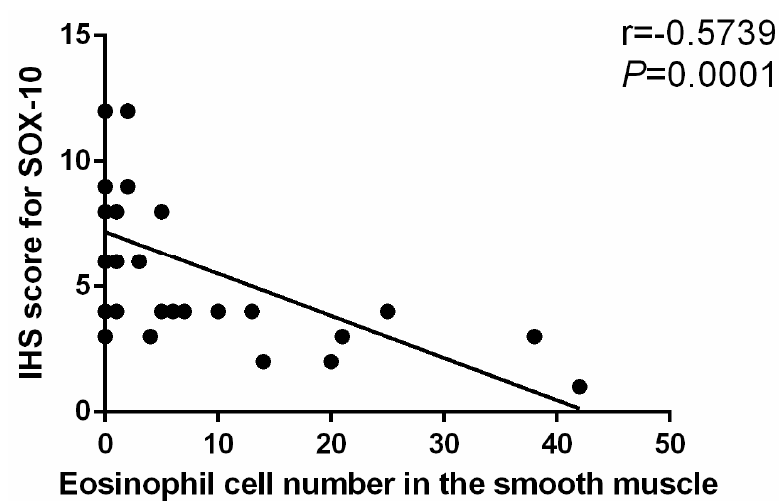
Figure 9. The correlation between eosinophil count and the SOX-10-IR Cells. The number of eosinophils in the smooth muscle layer of esophagus was negatively correlated with SOX-10-IR Cells. n = 40, r = − 0.5739, r 2 = 0.3294, p = 0.0001, 95% CI ( − 0.7512, − 0.3195). IHS: immuno-histochemical score. Spearman rank correlation was used.